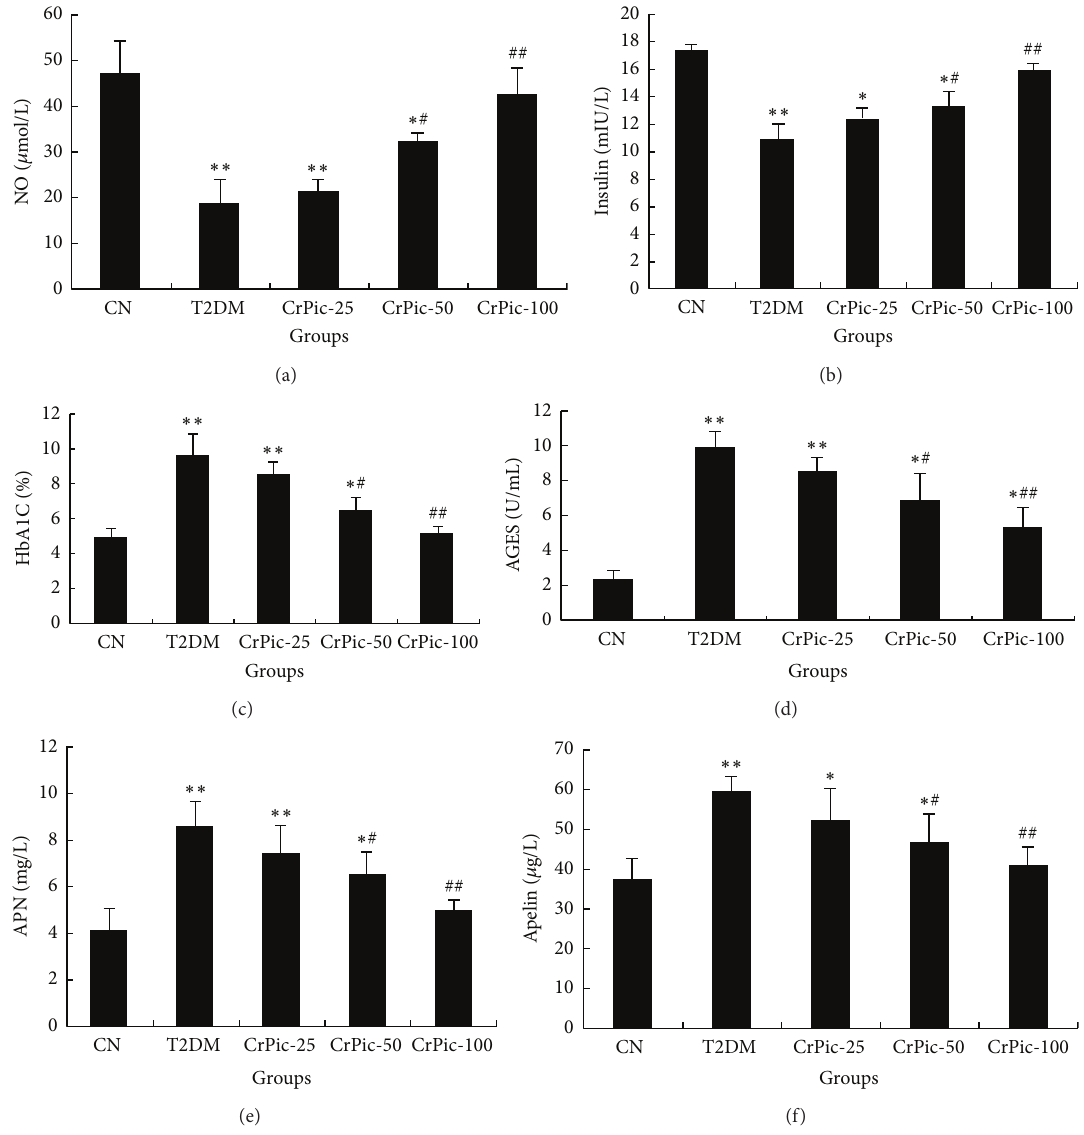
Figure 2: The effect of CrPic on the levels of serum NO (a), insulin (b), HbA1C (c), AGES (d), APN (e), and apelin (f). CN: the normal control group, group 1; T2DM: T2DM (type II diabetes mellitus) control group, group 2; CrPic-25: group 3 (25 𝜇 g/kg); CrPic-50: group 4 (50 𝜇 g/kg); and CrPic-100: group 5 (100 𝜇 g/kg). ∗∗ 𝑃 < 0.01 compared with group 1; ∗ 𝑃 < 0.05 compared with group 1; ## 𝑃 < 0.01 compared with group 2; and # 𝑃 < 0.05 compared with group